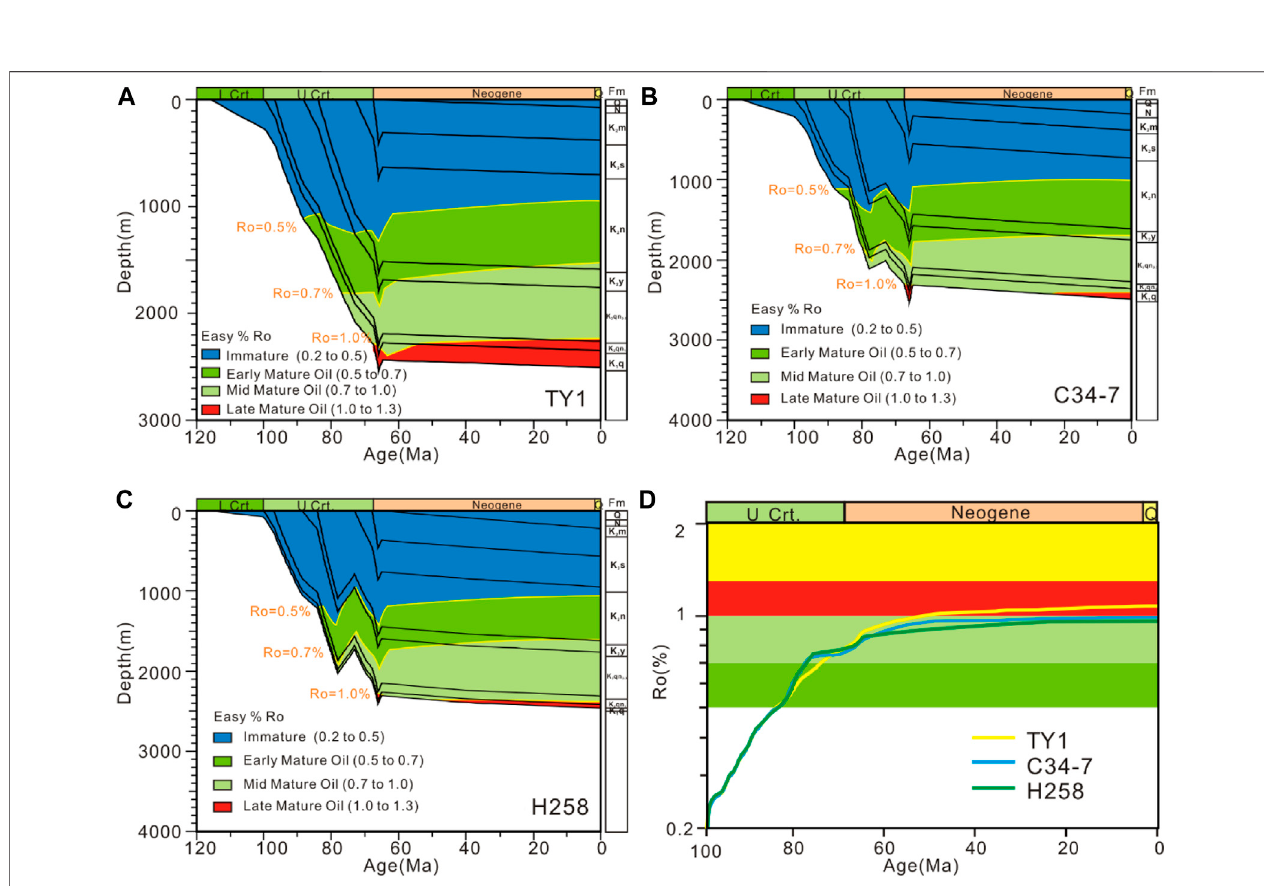
FIGURE8| ThermalmaturitymodeloftheTY1well (A) ,C34-7well (B) ,H258well (C) ,andtheevolutionpro fi leofvitrinitere fl ectance(Ro)ofthreetypicalwells (D) in the southern part of the Songliao Basin. Timing of hydrocarbon generation and primary migration.